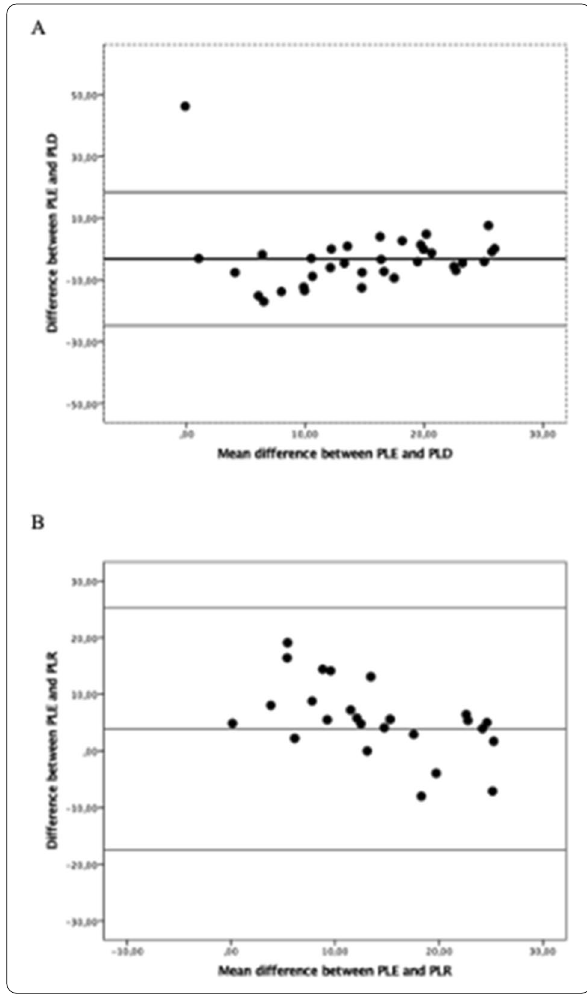
Figure Comparison of different formulas with Blant Altman graphic. Conclusion. Our results suggest that standardization of calculation method of inspiratory TPP is necessary before using it to estimate alve- olar overdistension.